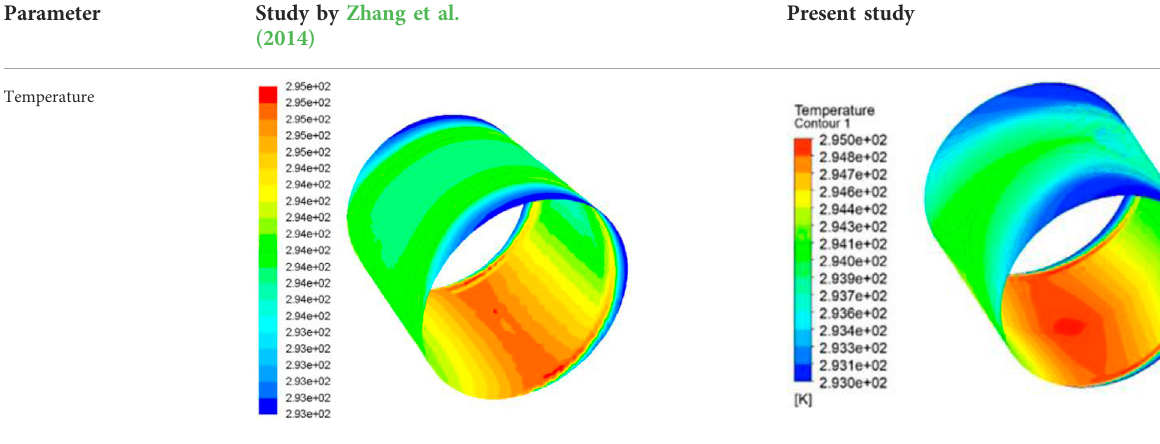
TABLE 3 Comparison contour of study reference and the present study.